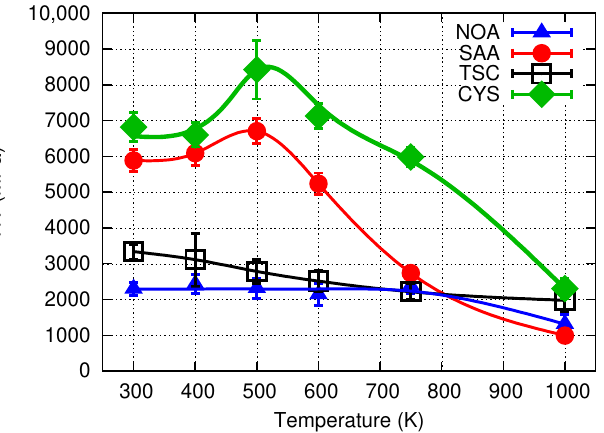
Figure 12. Vickers hardness (HV) as a function of the annealing temperature for the “es” side of the film CYS04 (denoted as CYS). In addition, the hardness evolution versus the temperature is also plotted for other additives, published formerly in Ref. [9]. NOA: no additive, SAA: saccharin, TSC: trisodium-citrate. The line serves as a guide for the eye